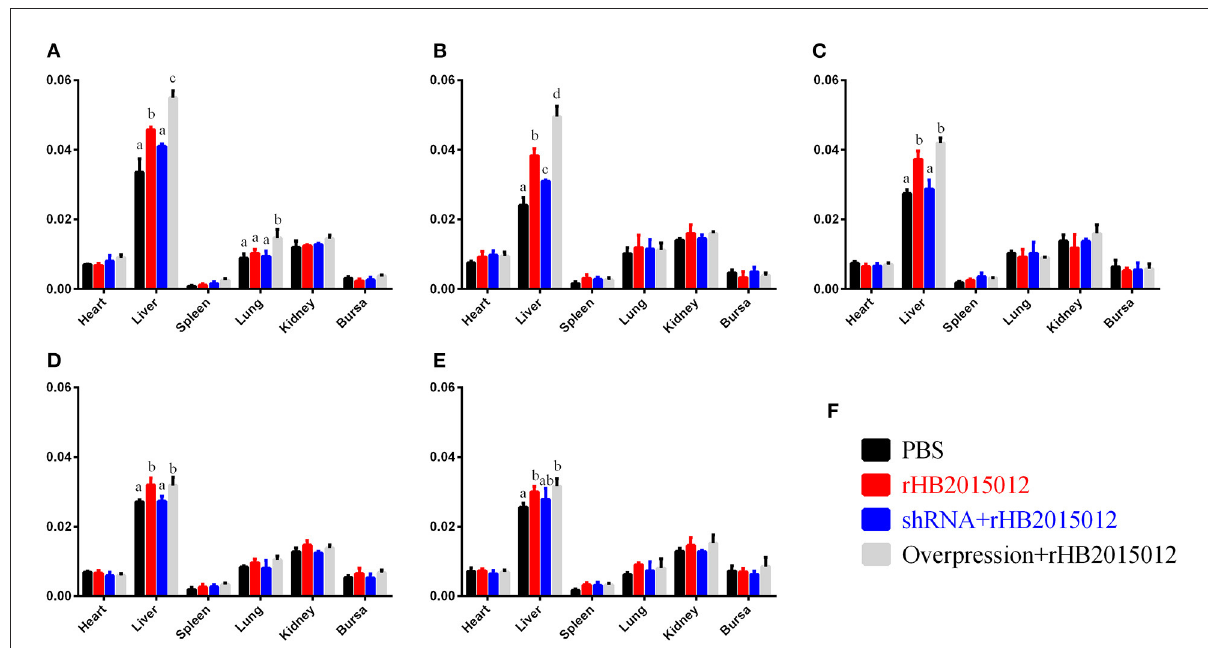
FIGURE5 Animal experimental organ index. (A–E) 7-, 14-, 21-, 28- and 35-day organ index. ALV-A rHB2015012 infection in A20-overexpressing chickens promotes the occurrence of hepatomegaly symptoms but does not promote or inhibit heart, spleen, lung, kidney and bursa. (F) Animal experiment group legend. a, b, c, and d indicate differences, with the same letter indicating no difference and different letters indicating a difference.